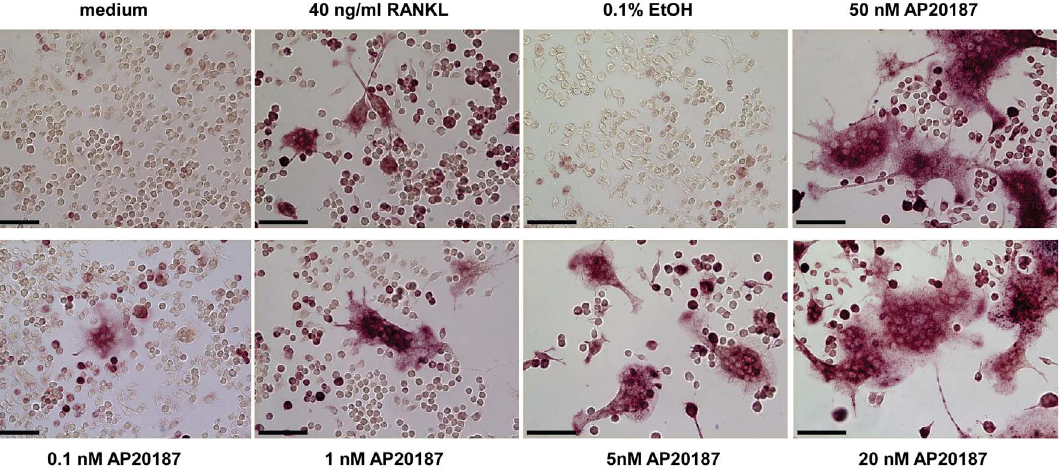
Figure 2. CID-responsiveness of the iRANK construct. RAW264.7 + iRANK cells were cultured in medium containing vehicle (EtOH), RANKL, or 0.1–50 nM AP20187 for 4 days and the cells were stained for TRAP. RANKL and AP20187 induced multinucleated TRAP-positive cells were observed (purple staining) (scale bars=100 m m).